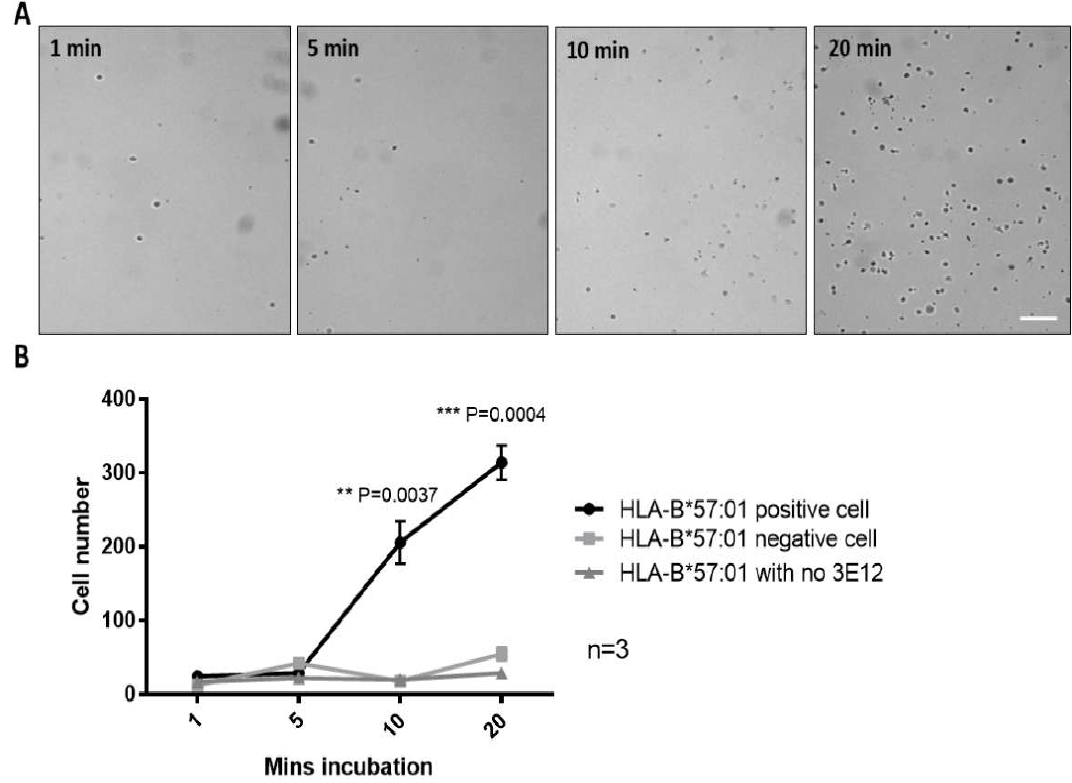
Figure 3. HLA-B*57:01 expressing cell line capture over time. ( A ) HLA-B*57:01 positive cells captured on a glass surface functionalized with a 3E12 antibody at 1 min, 5 min, 10 min and 20 min of incubation. ( B ) A Significant increase in the number of HLA-B*57:01 positive cells were captured from 10 min of incubation compared to HLA-B*57:01 negative cells and no antibody control at 0.5 mm 2 area (mean ± SEM. Bar = 100 μm).